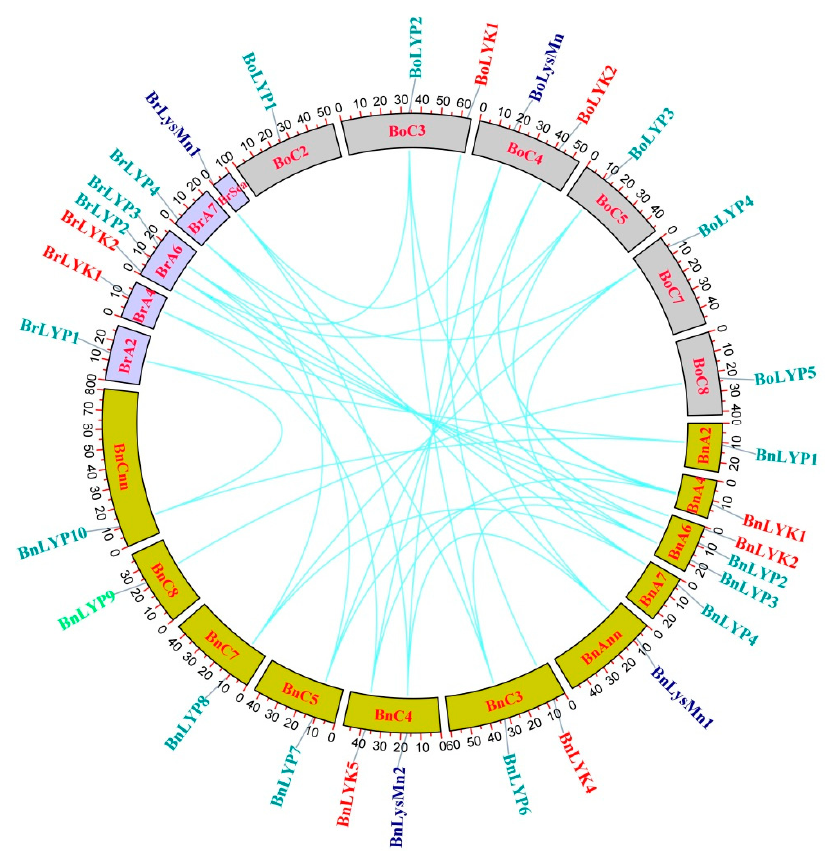
Figure 2. The chromosomal location of LysM-RLK genes and the duplication relationship between them. Colored boxes represent chromosomes. Curves are used to show gene duplications.